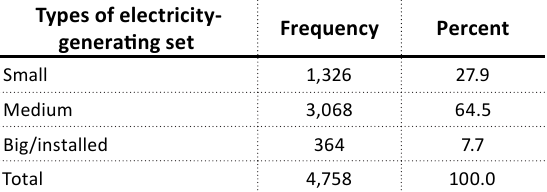
Table 14. Distribution of types of electricity- generating